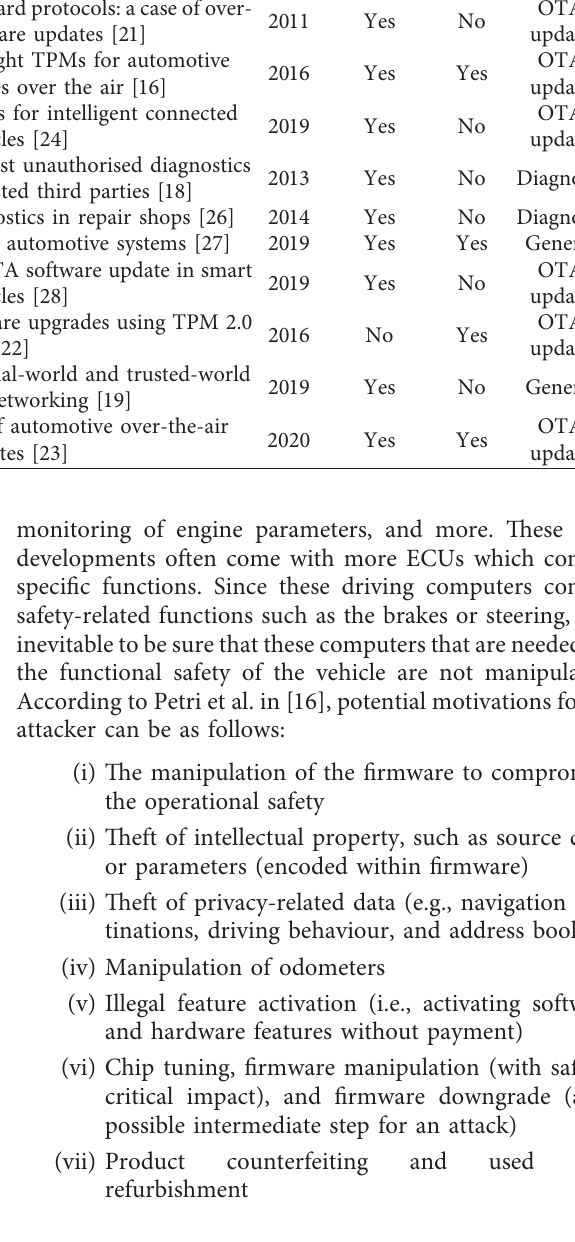
Table 1: Overview of the relevant research literature in the field of trusted automotive, diagnosis, and over-the-air update.